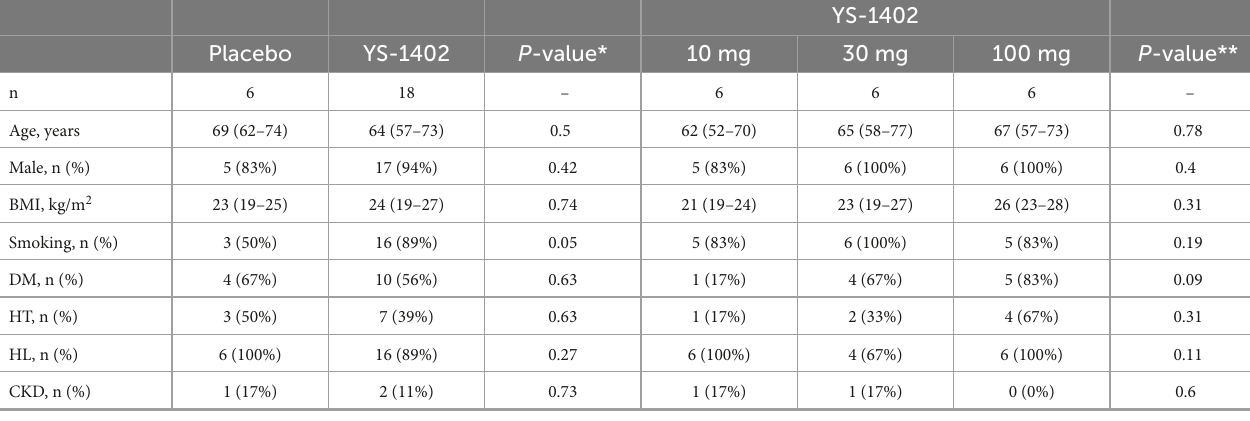
TABLE 1 Patient characteristics.